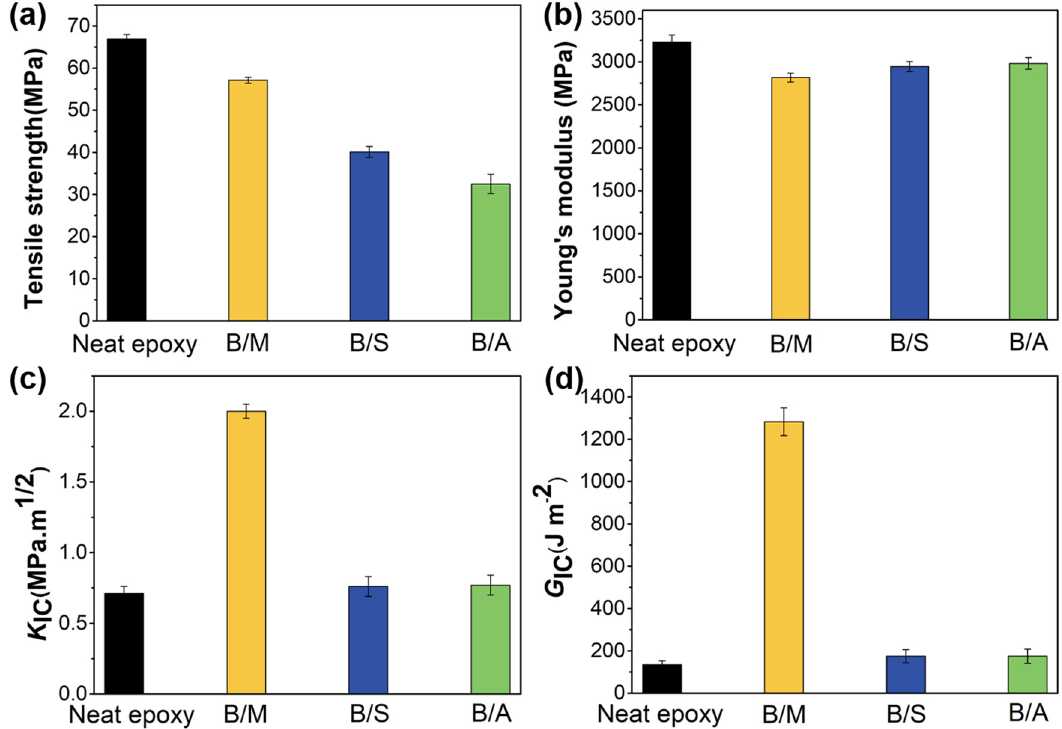
Figure 6: Mechanical properties of neat and nanoparticle - containing epoxy resins: ( a ) tensile strength, ( b ) Young ’ s modulus and ( c and d ) fracture